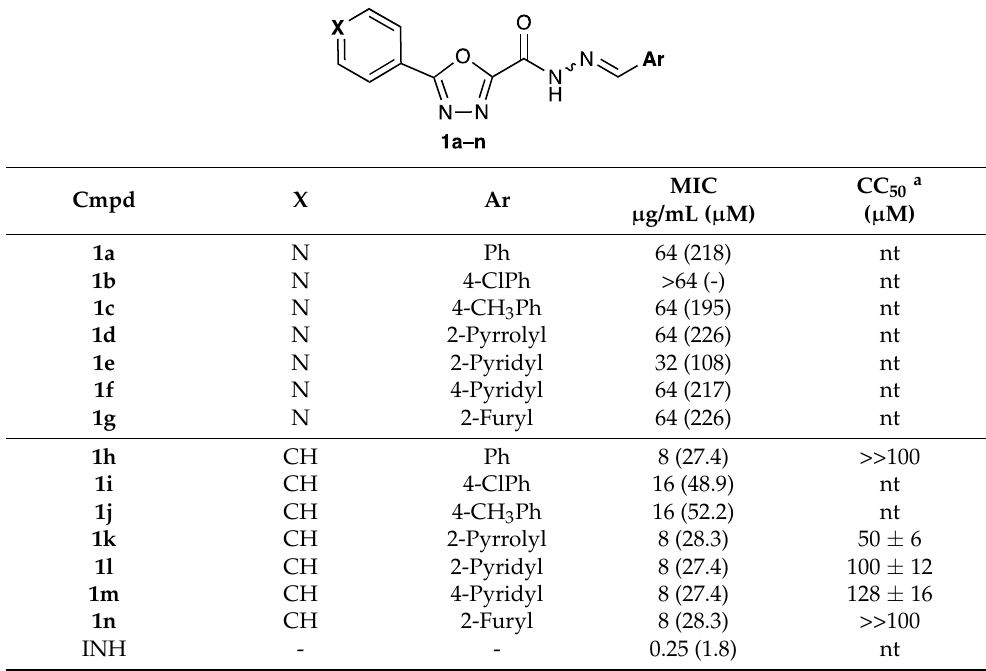
Table 1. Antimycobacterial activity of the final compounds 1a–n against M. tuberculosis H37Ra strain and cytotoxicity concentration for the most active compounds (CC 50 ).